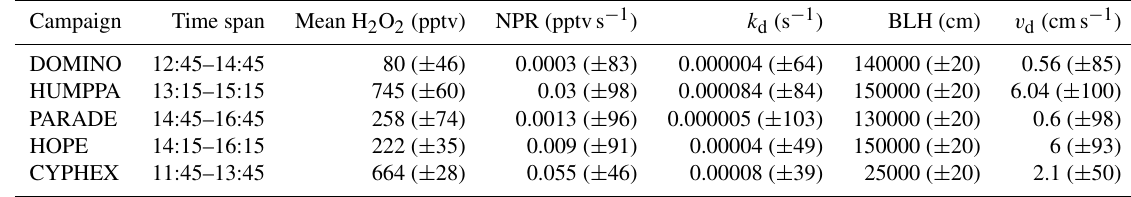
Table 4. Calculation of dry deposition loss L dep and entrainment rate P ent . Uncertainties are reported in %. Campaign